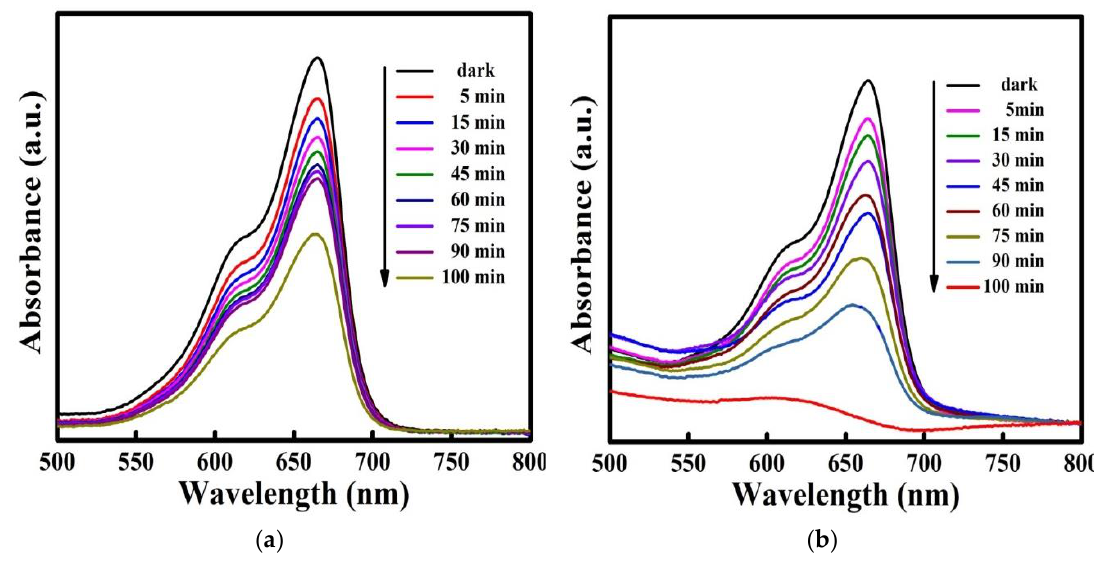
Figure 10. Photodegradation of MB dye in aqueous solution under visible light for ( a ) SnS 2 and ( b ) SnS 2 -SiO 2 @α -Fe 2 O 3 (SSF-15 wt %) nanocomposites.